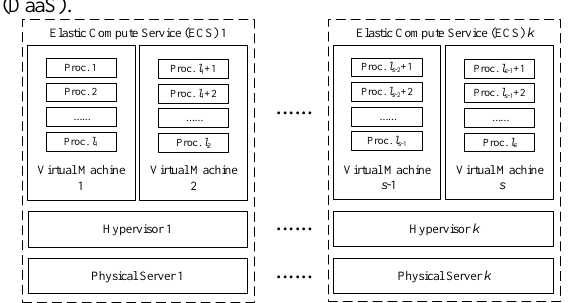
Figure 6 . Architecture of Cloud Service System Resource